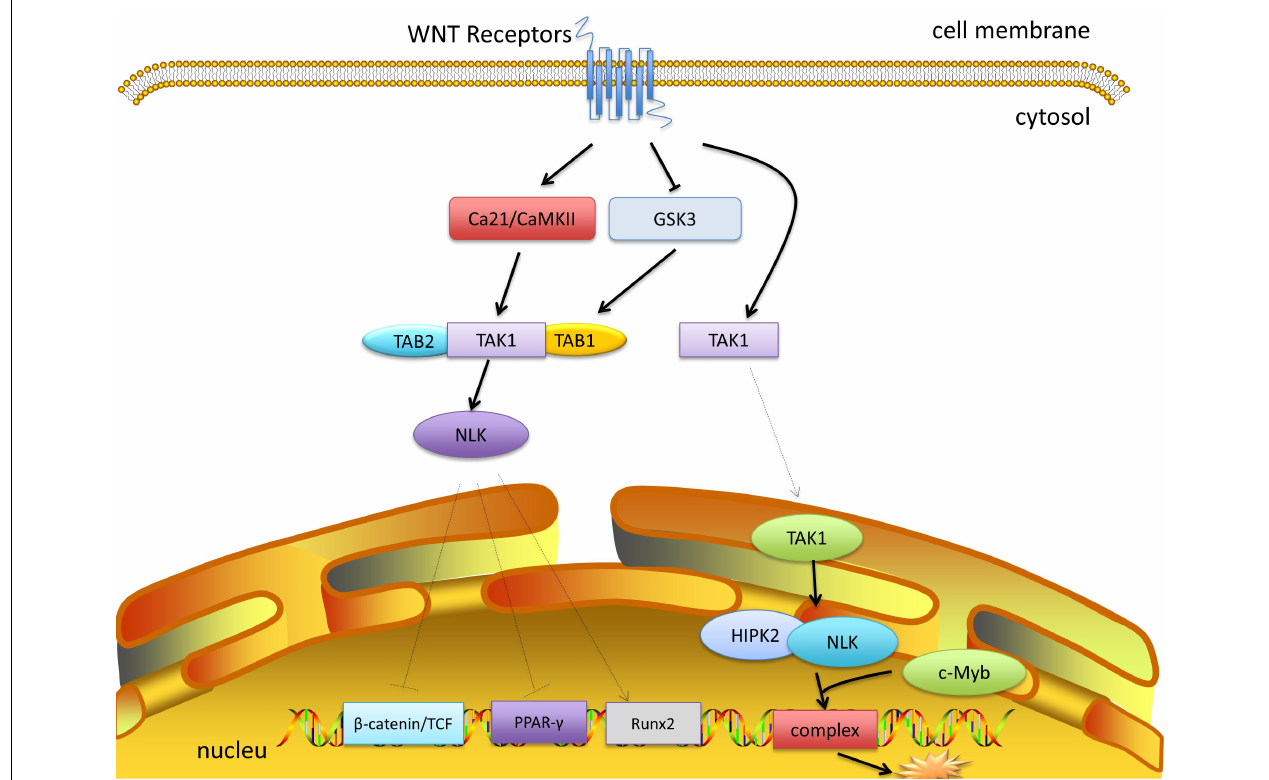
FIGURE 3 | TAK1 and WNT signaling. WNT receptors inhibit the activity of GSK3, which stabilizes the TAB1-TAK1 complex and activates TAK1. WNT-5A signaling can activate Ca21/CaMKII, which promotes the activation of TAK1 and NLK. NLK inhibits the transcriptional activation of β -catenin and TCF, and inhibits PPAR- γ , and activates Runx2. Moreover, after moving into the nucleus, TAK1 recruits HIPK2 and NLK, which bind c-Myb to form a complex and mediate its